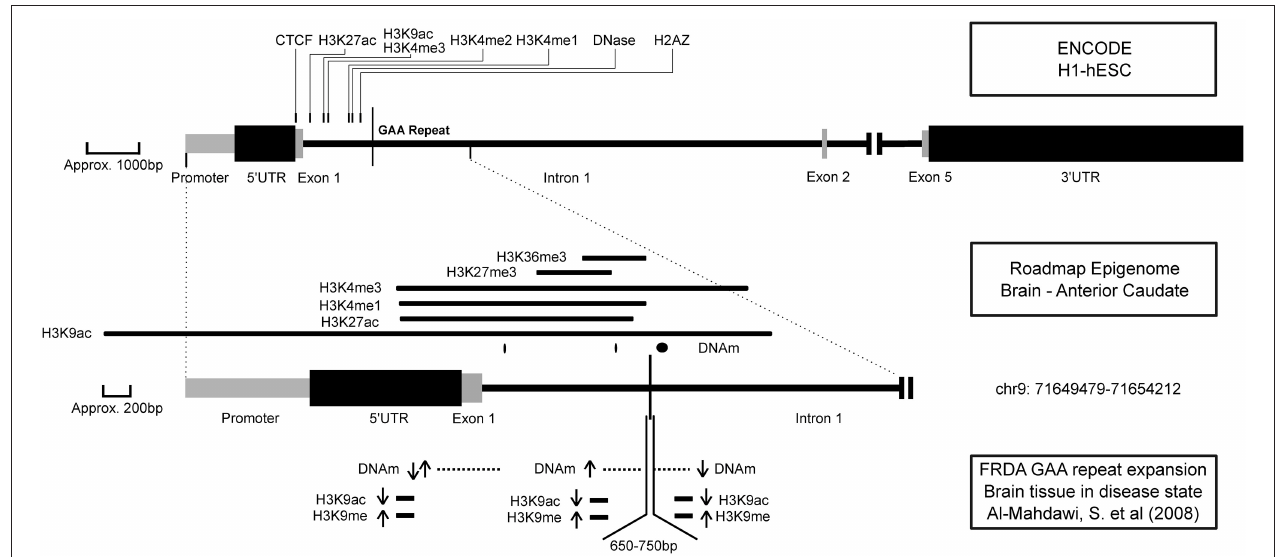
FIGURE 2 | The epigenetic environment of FRDA. A representation of epigenetic marks with their location around the Frataxin gene (NM_000144) across three experimental data sets (named in the right margin). Upper panel: Marks are displayed if they are significantly close to the GAA repeat according to M3. Middle panel: The full-width peaks for each mark around the GAA repeat according to the Roadmap Epigenome for healthy brain tissue. Lower panel: Changes in epigenetic marks as observed in brain tissue, based on differences between normal and diseased state ( Al-Mahdawi et al., 2008). Locations where DNAm and histone assays were performed are shown. Arrows indicate a significant increase or decrease in methylation and histone binding at these locations. The size of the GAA repeat expansion in the disease state is also